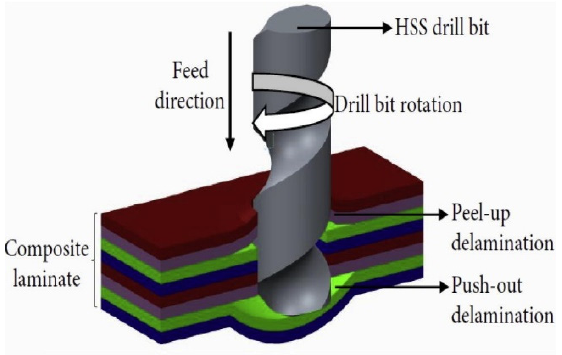
Figure 1. Mechanism of delamination in composite laminate drilling [50].